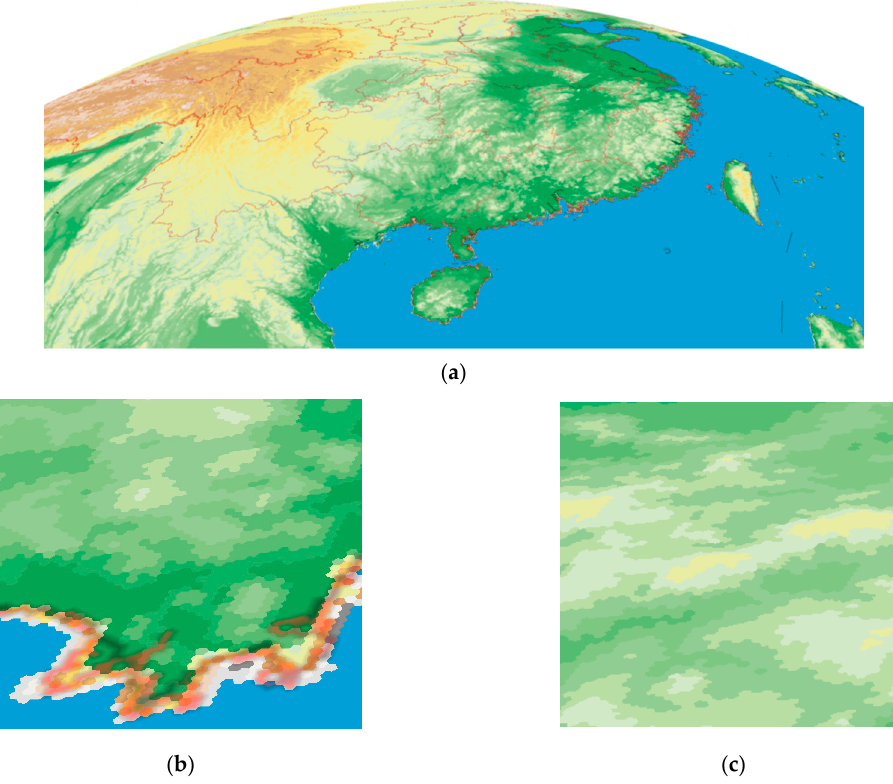
Figure 14. Details of the resampling results of GTOPO30 dataset based on the mixed aperture 3 and 4 scheme: ( a ) involves the area of China; ( b ) and ( c ) are more detailed figures to show the hexagonal cells more clearly (source—own study).